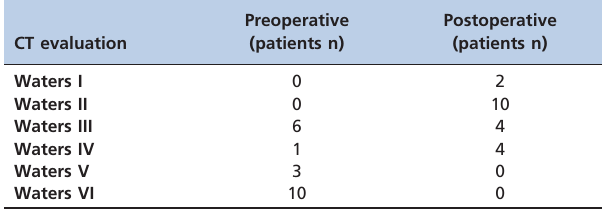
Table 4 - Pre- and postoperative CT